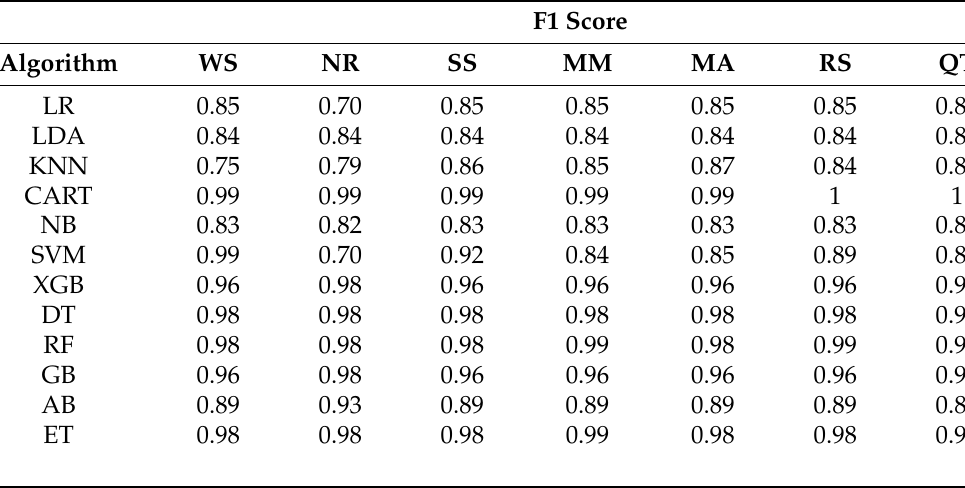
Table 8. Overall performance of different algorithms based on F1 score.